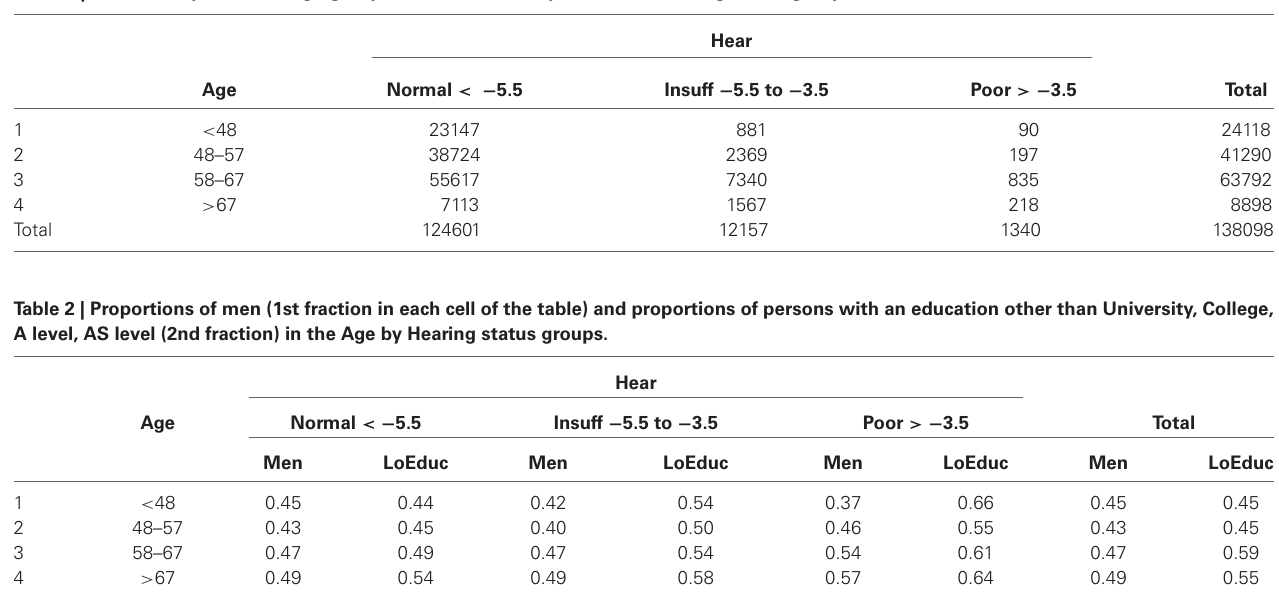
Table 1 | Number of persons in Age-groups and the three-step functional hearing status groups.